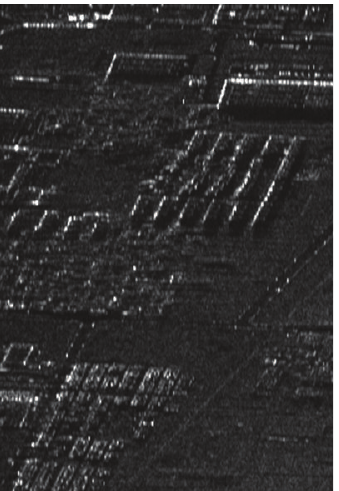
Figure 3: The tested SAR data of urban.